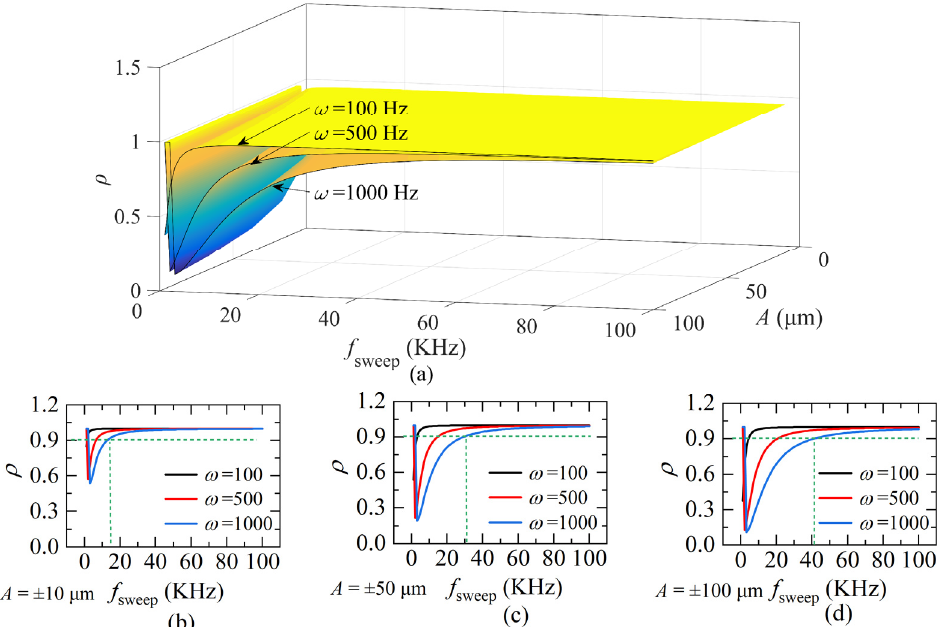
Figure 7. ( a ) The quasi-static coefficient ρ of different f sweep , the frequency ω of the distance and the the amplitude A ; ( b ) ρ when A = ± 10 µ m; ( c ) ρ when A = ± 50 µ m; ( d ) ρ when A = ± 100 µ m amplitude A ; ( b ) ρ when A = ±10 μ m; ( c ) ρ when A = ±50 μ m; ( d ) ρ when A = ±100 μ m ( L (0) = 800 ( L (0) = 800 µ m, ∆ u = 5.1 × 10 12 Hz, u a = 1.9365 × 10 14 μ m, Δ u = 5.1 × 10 12 Hz, u a = 1.9365 × 10 14 Hz).